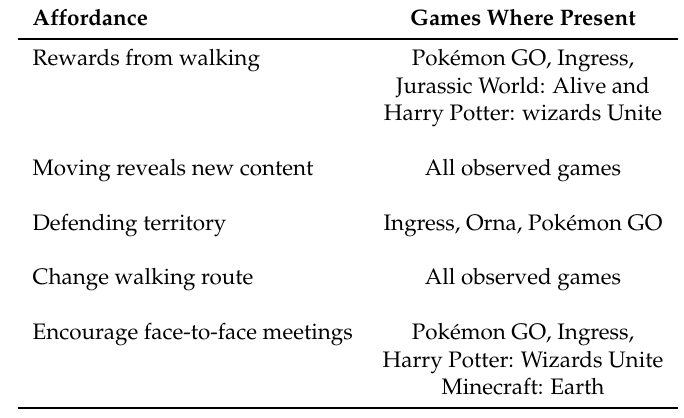
Table 3. Affordances of the seven observed LBGs for influencing player movement in the real world. Affordance Games Where Present Rewards from walking Pokémon GO, Ingress, Jurassic World: Alive and Harry Potter: wizards